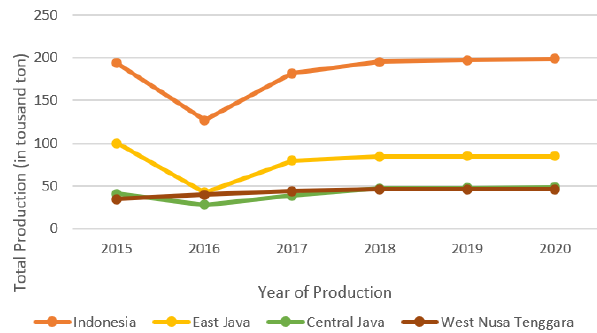
Figure 1. Tobacco production in Indonesia (2015-2020)